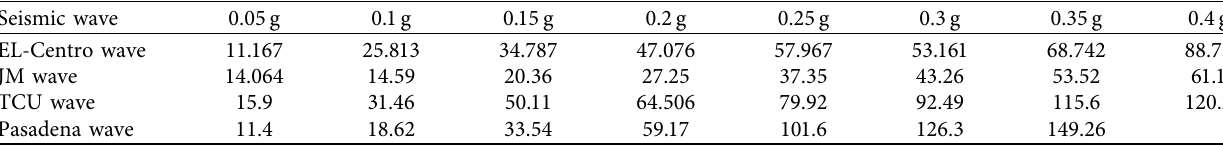
Table 1: Test sloshing wave height (in millimeters).